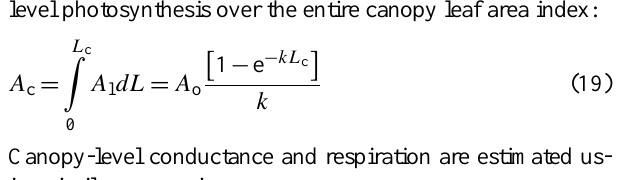
Broadleaf Needleleaf C 3 C 4 Shrub tree tree grass grass Extinction coefficient for PAR 0.50 0.50 Quantum efficiency Leaf scattering coefficient for PAR Dark respiration coefficient Growth respiration coefficient Top leaf Nitrogen concentration Ratio of Nitrogen concentrations in roots and leaves